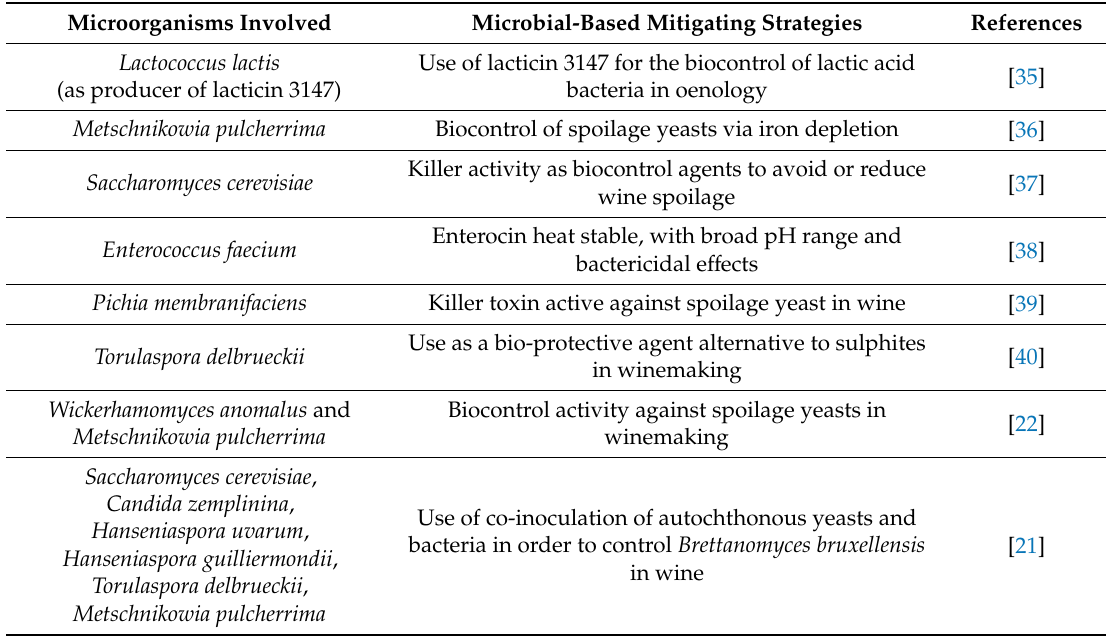
Table 2. A list of studies that propose microbial-based solutions that can have potential applications in mitigating the development of spoilage microorganisms in wine. Microorganisms